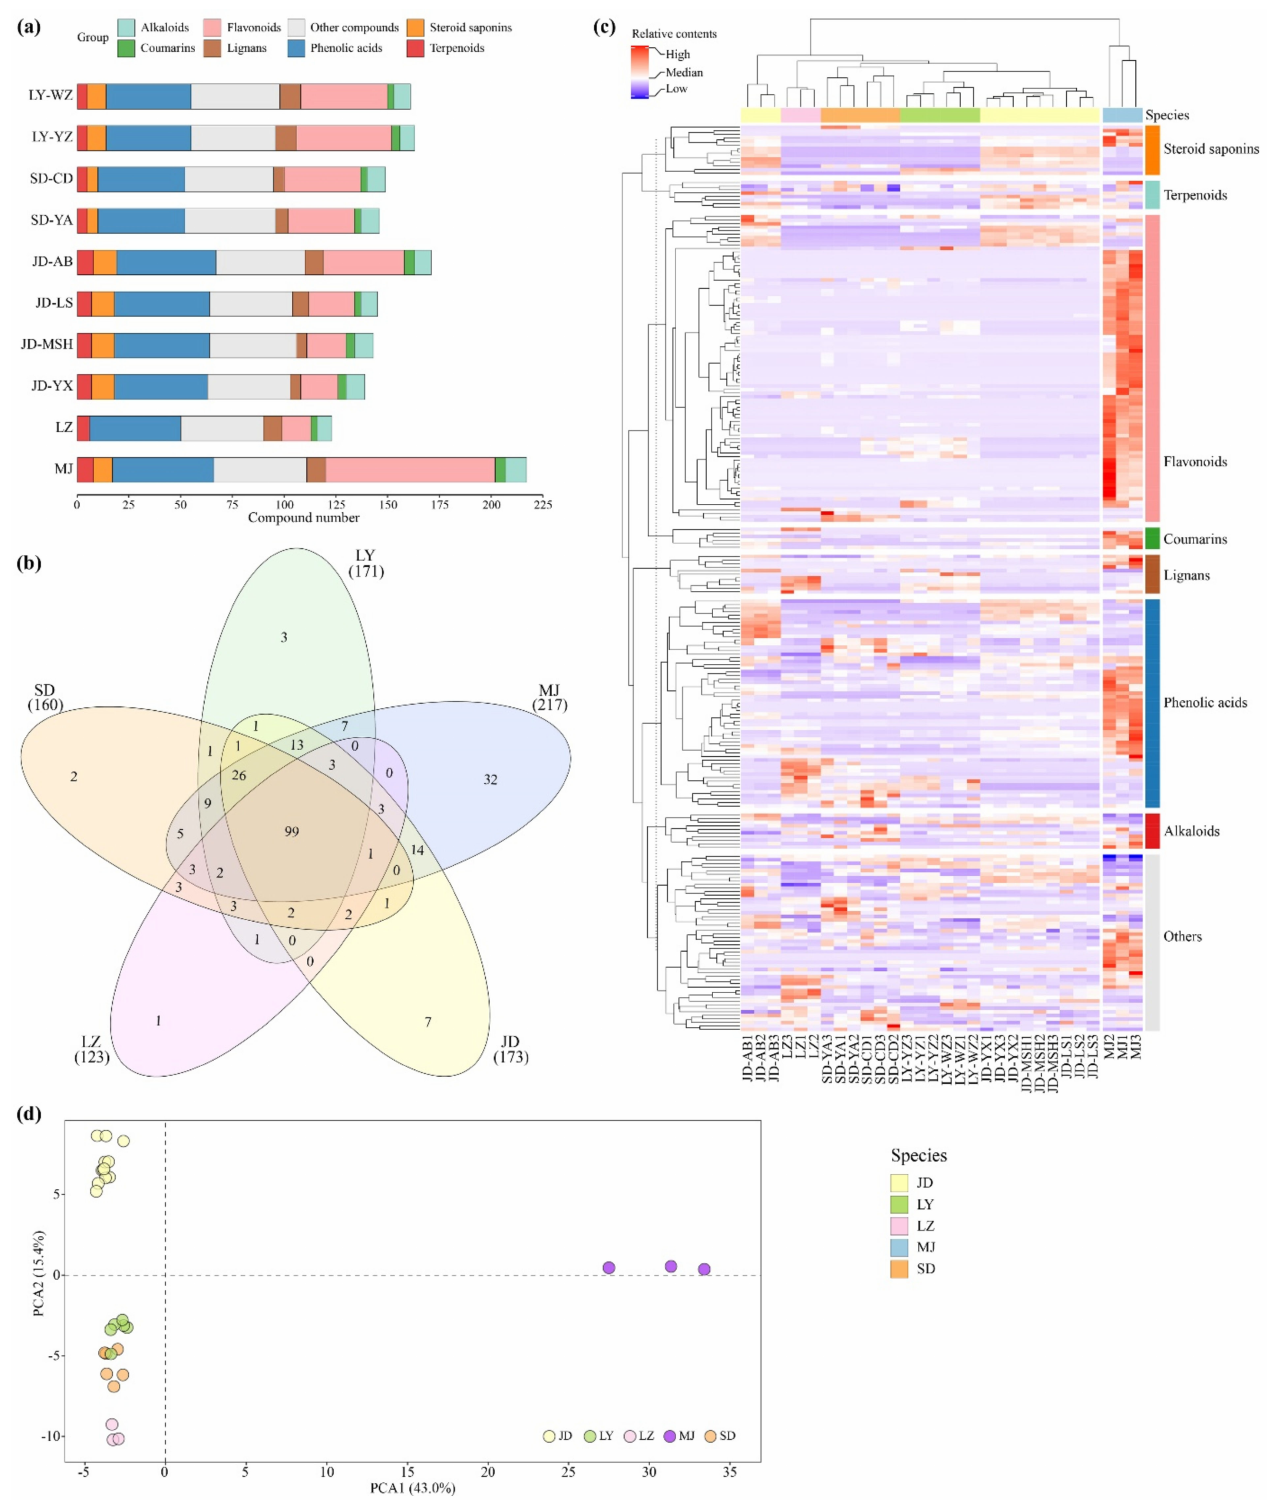
Figure 1. Secondary metabolite profiles of ten lily samples belonging to five different species. ( a ) The number of secondary metabolites detected in ten lily samples; ( b ) Venn diagrams for displaying the number of commonly and specific metabolites among five Lilium species; ( c ) Hierarchical cluster analysis and heatmap of metabolite profiles of ten lily samples. Clustering distance method ”Pearson”, hierarchical clustering method “complete”; ( d ) Principal component analysis and scores plot for ten lily